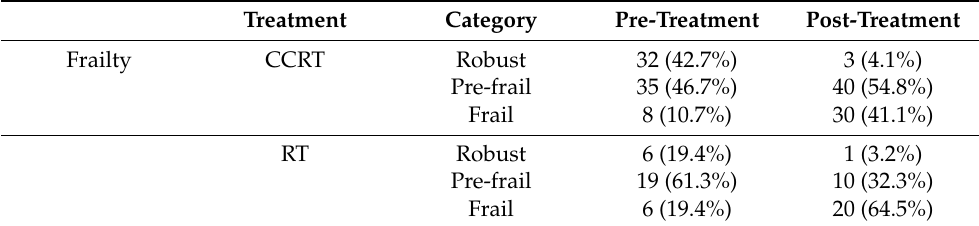
Table 5. Frailty distribution.